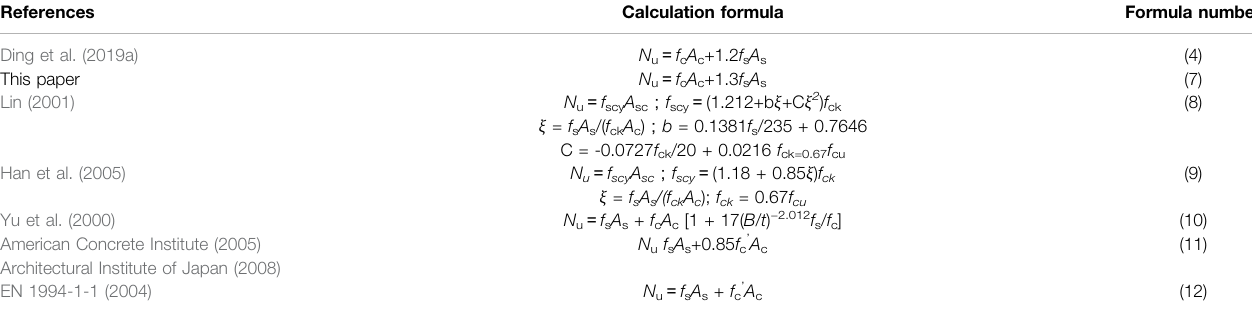
TABLE 4 | Practical main calculation formula for bearing capacity of square steel tube